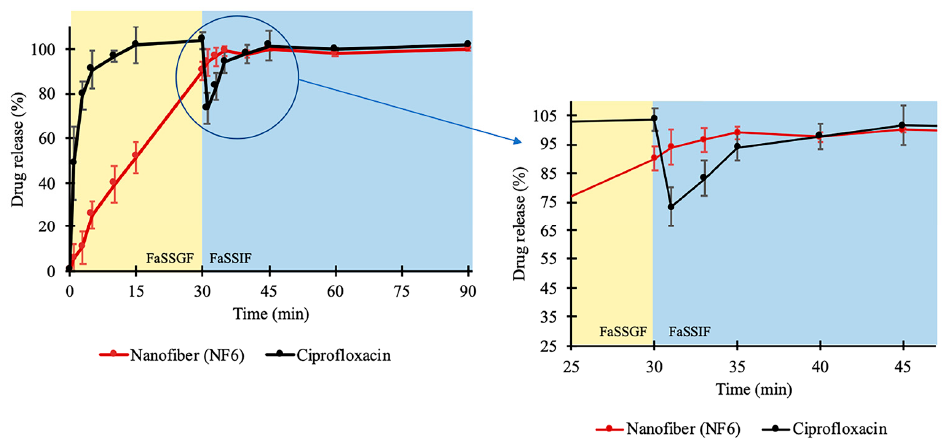
Figure 5. In vitro dissolution of ciprofloxacin (CIP) from NF6 nanofiber and CIP powder during the two-stage biorelevant release study. The dissolution medium (FaSSGF) simulated gastric condition until 30 min when the medium was turned into FaSSIF biorelevant fluid. The time range around the change of the medium (25–45 min) is magnified for better visualization.